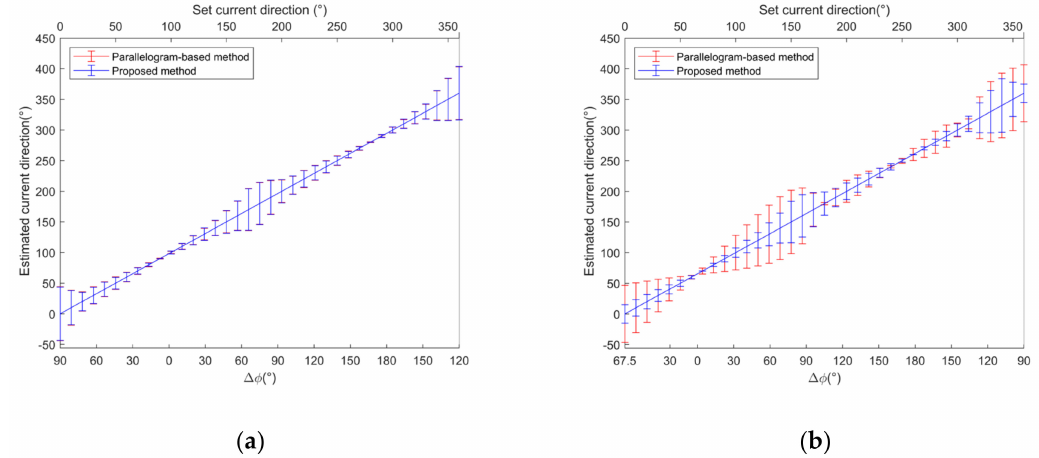
Figure 8. Error bar graphs of derived velocity direction for different vector determination methods. ( a ) β = 90 ◦ ( b ) β (cid:54) = 90 ◦